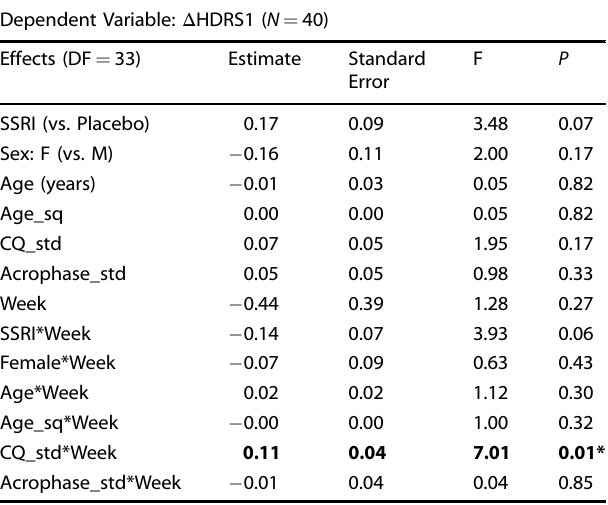
Table 3. Results of the repeated measures analysis of variance with linear mixed model to assess the relationship between parametric circadian rhythm measures, collected during fi rst week of treatment, and change in depression after that fi rst week of